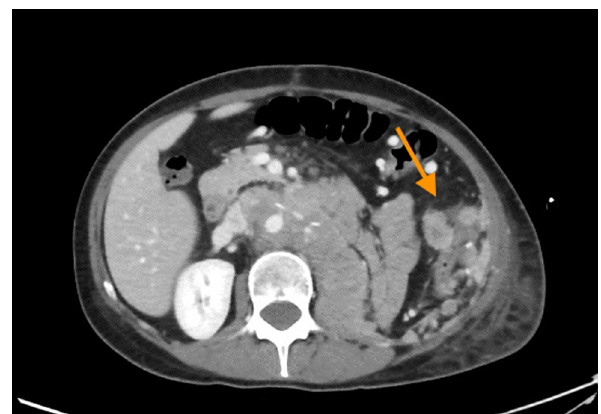
Figure 4: CT - scan, the imaging revealed a peritoneal carcinomatosis ( arrow )